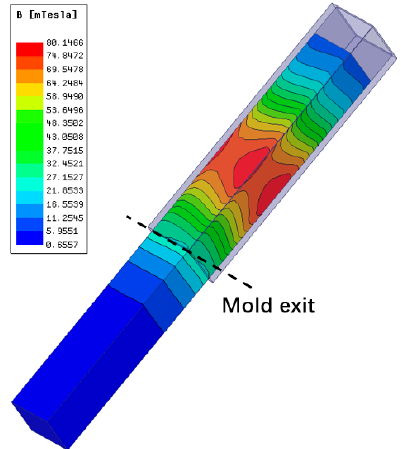
Figure 7. Contour plot of time-averaged magnetic flux density on the strand surface at 500 A/3 Hz.